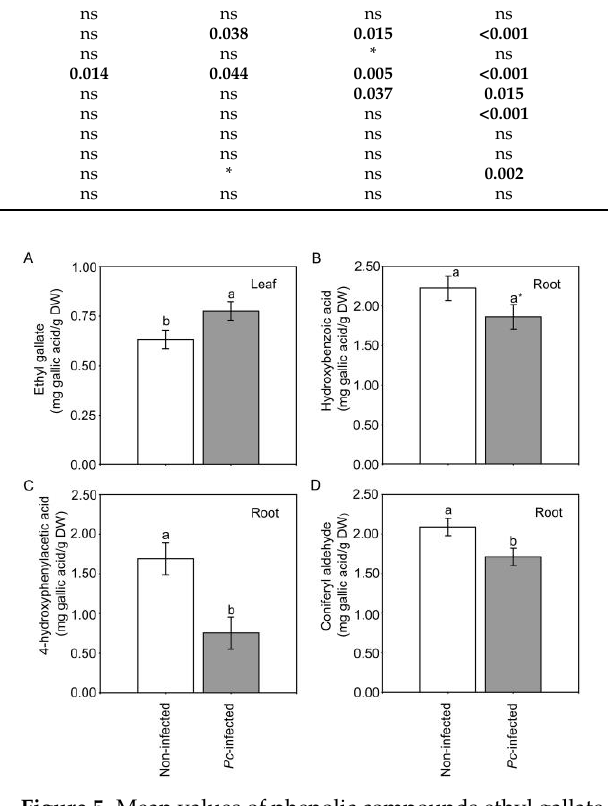
Figure 5. Mean values of phenolic compounds ethyl gallate ( A ), hydroxybenzoic acid ( B ), 4-hydroxyphenylacetic acid ( C ), and coniferyl aldehyde ( D ) of Castanea sativa seedlings not infected or infected with Phytophthora cinnamomi ( Pc ). According to the linear mixed models shown in Table 4, the four compounds were significantly affected by Pc infection. Measurements were taken 10 days after inoculation. Vertical bars are standard errors, different letters indicate significant differences ( p < 0.05), and the asterisk indicates a marginally significant difference ( p < 0.10) (Tukey’s HSD tests).